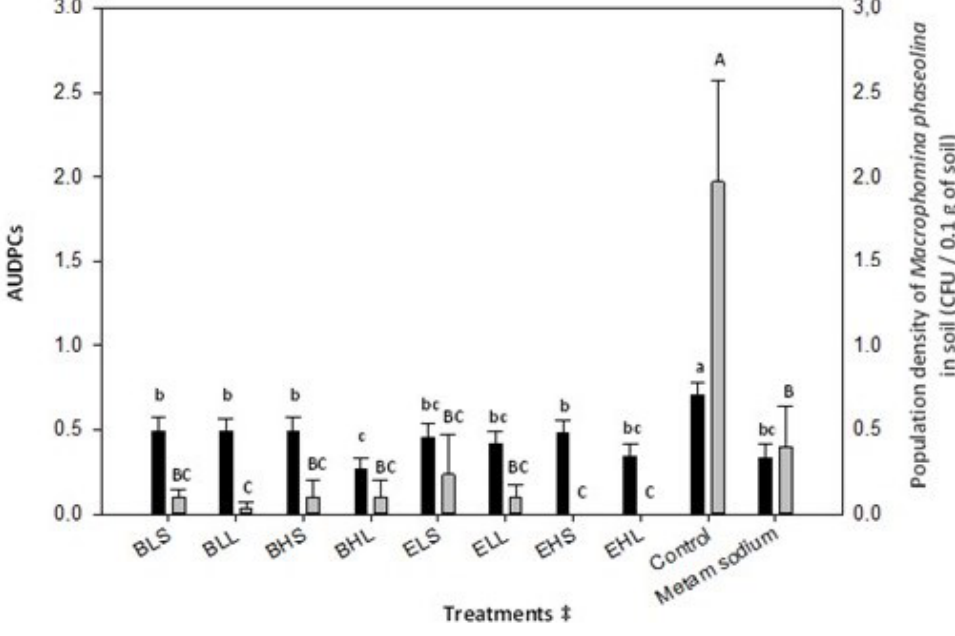
Figure 1. Effect of treatment on plant disease foliar severity as the standardized area under disease progress curve (AUDPCs) and population density of Macrophomina phaseolina . Black bars represent the strawberry plant disease foliar severity as the standardized area under disease progress curve (AUDPCs), and grey bars represent the population density of M. phaseolina in soil after ASD treatments. The lines above the bars represent the standard errors. Different lowercase or uppercase letters in the columns indicate significant differences according to the ANOVA test, followed by the LSD test ( p < 0.05). AUDPC data were not transformed for ANOVA, and the population density of M. phaseolina in soil data was transformed with (x + 1) 0.5 ; n = 18 and n = 6 for both variables, respectively. ‡ Treatments are shown in Table 3.